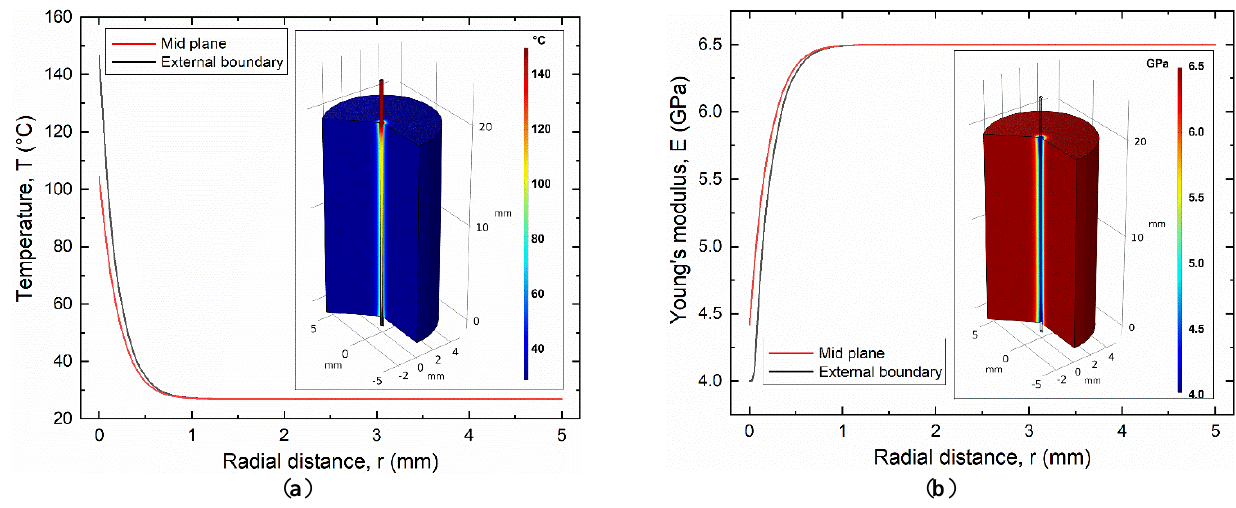
Figure 16. Effects of electric activation of the SMA wire by a pulse current (3 A, 0.75 s) as obtained from FE simulations: ( a ) temperature distribution and ( b ) Young’s modulus in the SMA–polymer sample.